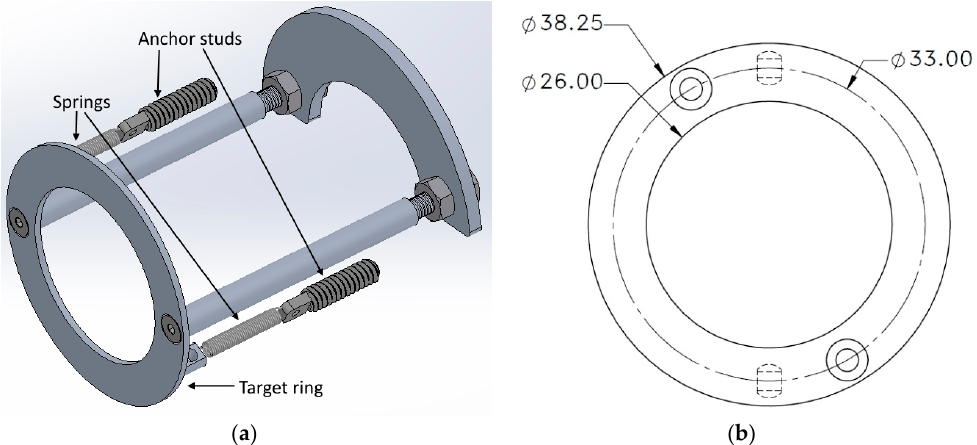
Figure 4. ( a ) Partially assembled release mechanism showing the target ring on the left, the release pins connected to the release plate on the right and the springs and anchor studs. ( b ) Target ring (top view), dimensions in mm.